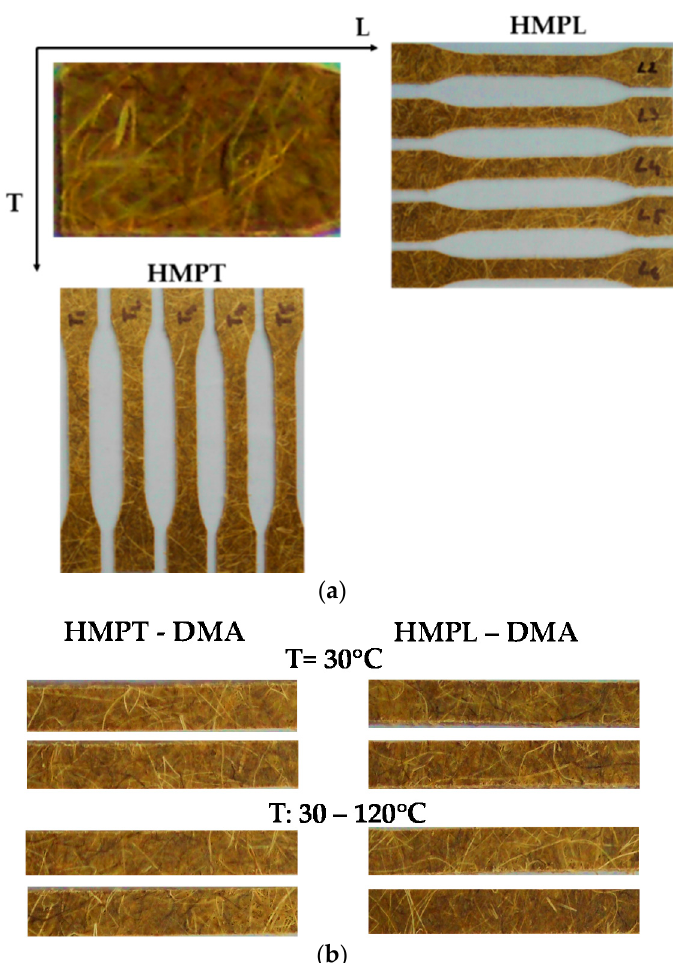
Figure 2. The specimens made from hemp mat reinforced and polyurethane resin: ( a ) geometry for tensile test: HMPL—sample cut in longitudinal direction; HMPT—sample cut in transversal direction; ( b ) geometry for the DMA test: HMPL—sample cut in longitudinal direction; HMPT—sample cut in transversal direction. Table 2. The characteristics of the polyester resin type 440-M888 Polylite, at 23 °C.